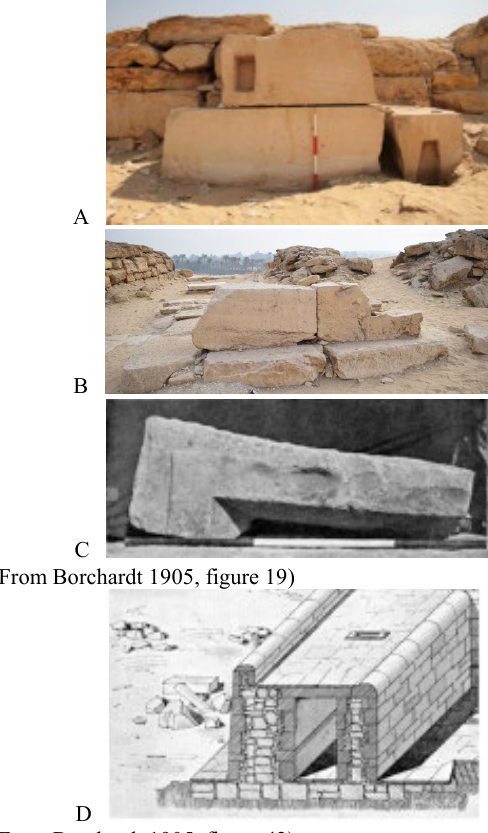
Figure 5: Images of closure elements related to table 1.